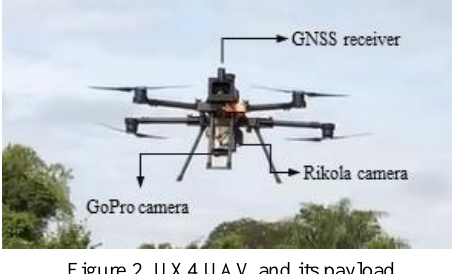
Figure 2. UX4 UAV and its payload